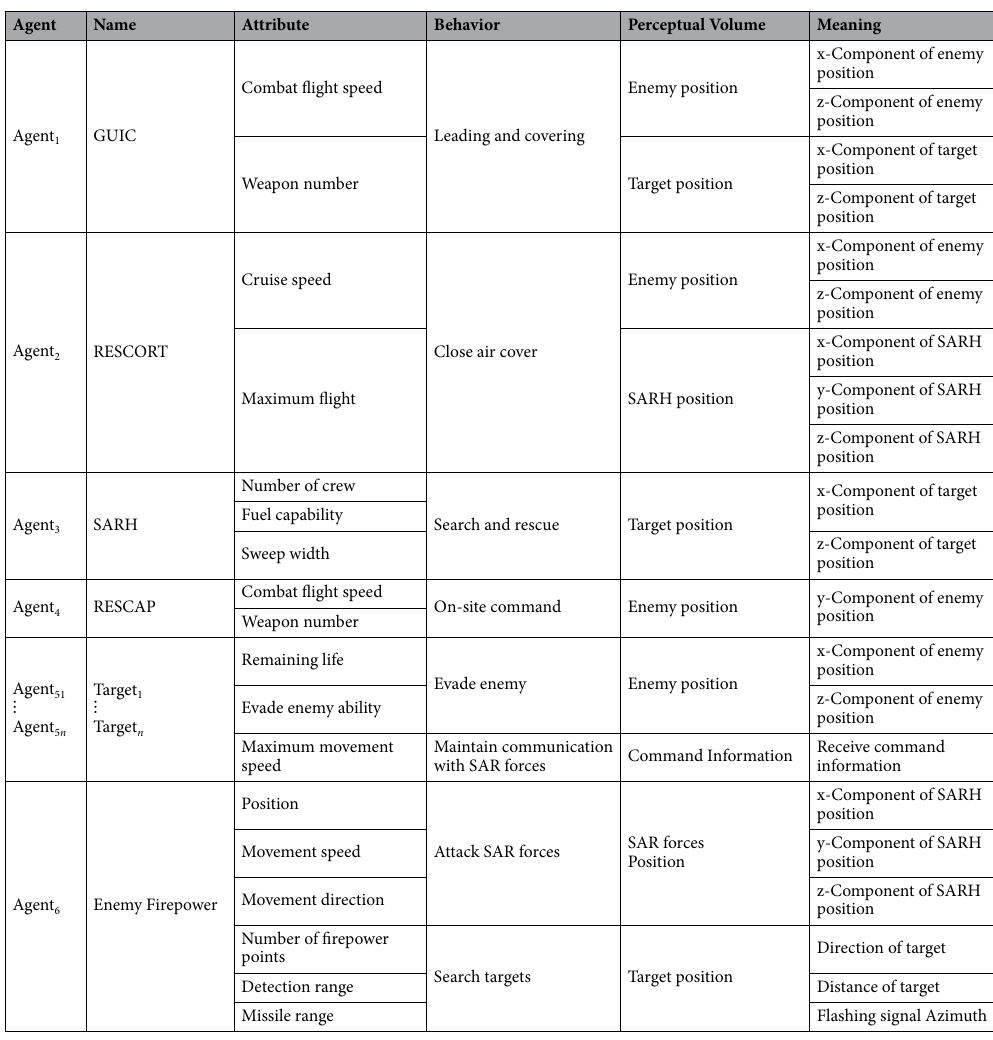
Table 3. Agent model of the aviation equipment, targets and enemy firepower.